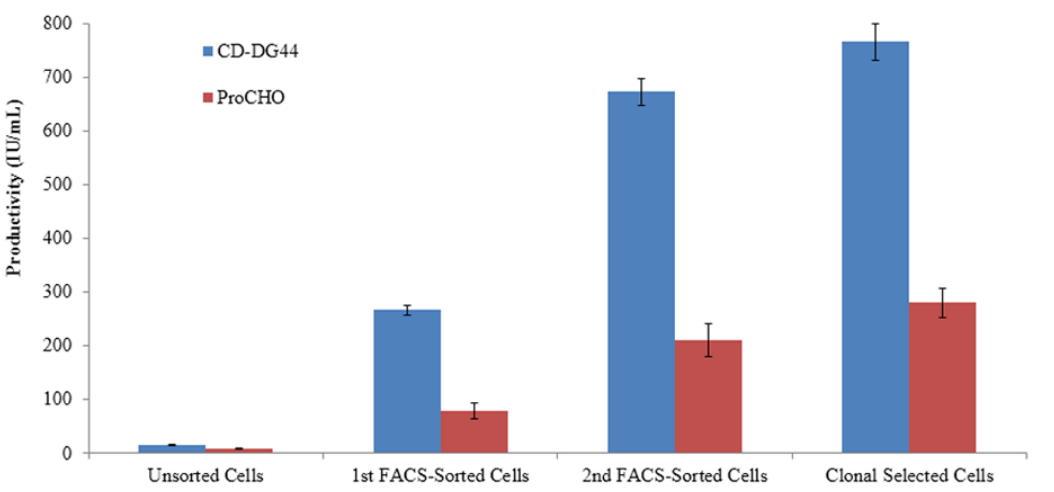
FIGURE 7 - Amidolytic activity test at each step for each